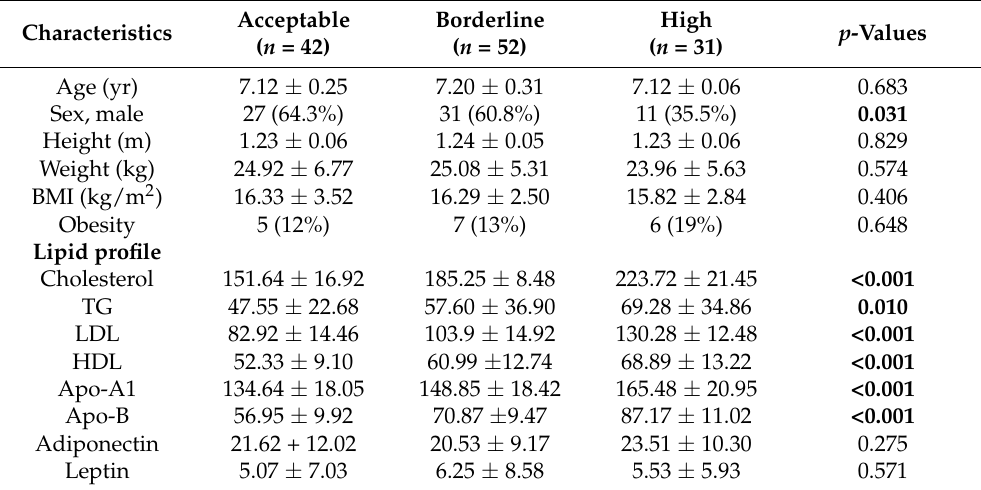
Table 1. Baseline characteristics of 125 children in relation to different status of cholesterol level.